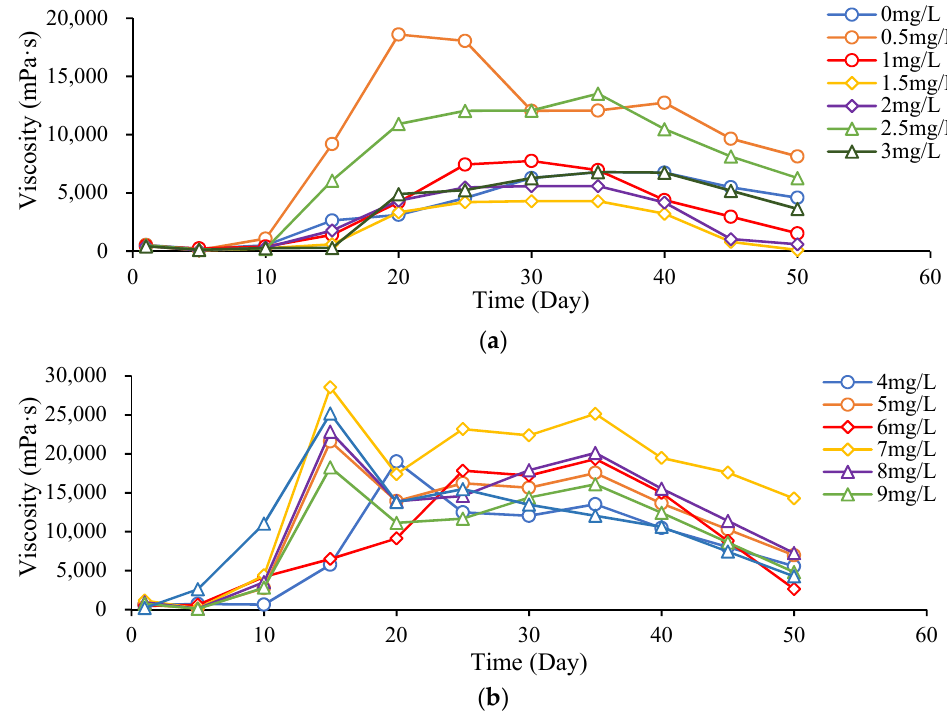
Figure 3. Effect of dissolved oxygen content on the gel strength of weak gels. ( a ) 0 – 3 mg/L Dissolved oxygen content. ( b ) 4 – 10 mg/L Dissolved oxygen content.